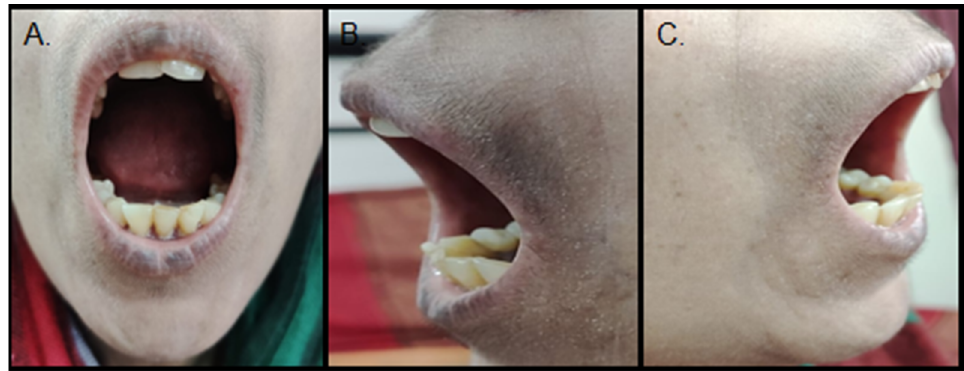
Figure 4. ( A )—Frontal view. ( B , C )—profile views showing improved mouth opening (30 mm) post muscle-stretching exercises and use of toothpaste and powered toothbrush.